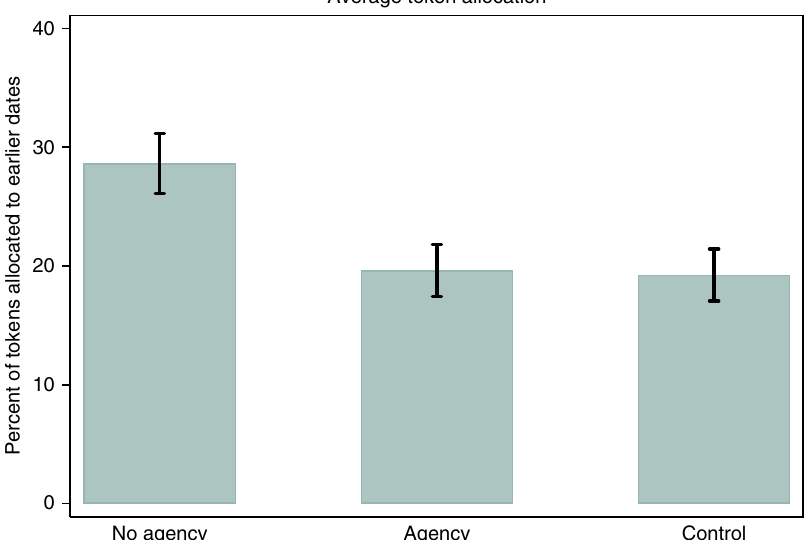
Fig. 1 Study 1 results: percent of tokens allocated to earlier dates, collapsing across allocation decisions. N = 211 participants. Error bars denote mean values ± 1 SE.